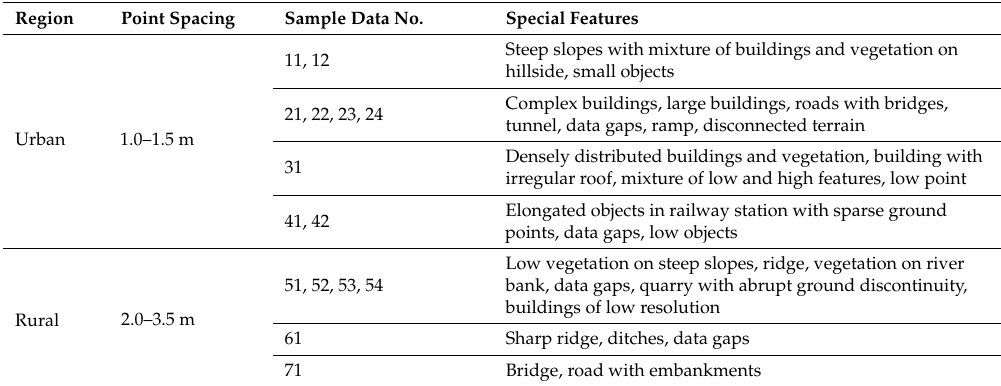
Table 1. Special features of the dataset selected by ISPRS for filter